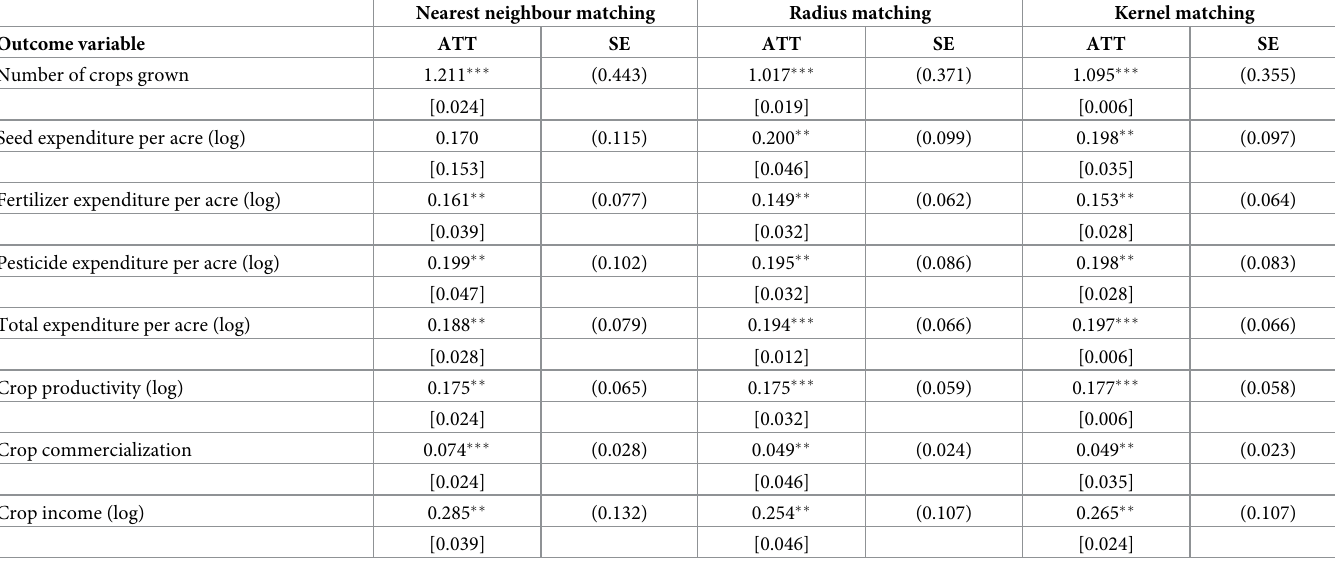
Table 5. Relationship between adoption of digital extension services and agricultural performance (PSM results).